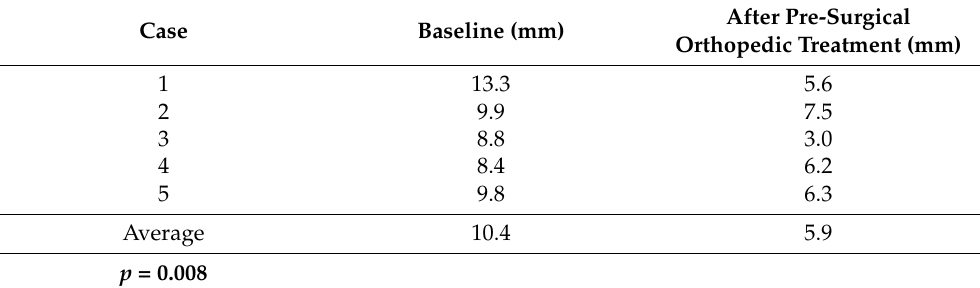
Table 2. Comparison of cleft lip width between baseline and after pre-surgical orthopedic treatment (middle